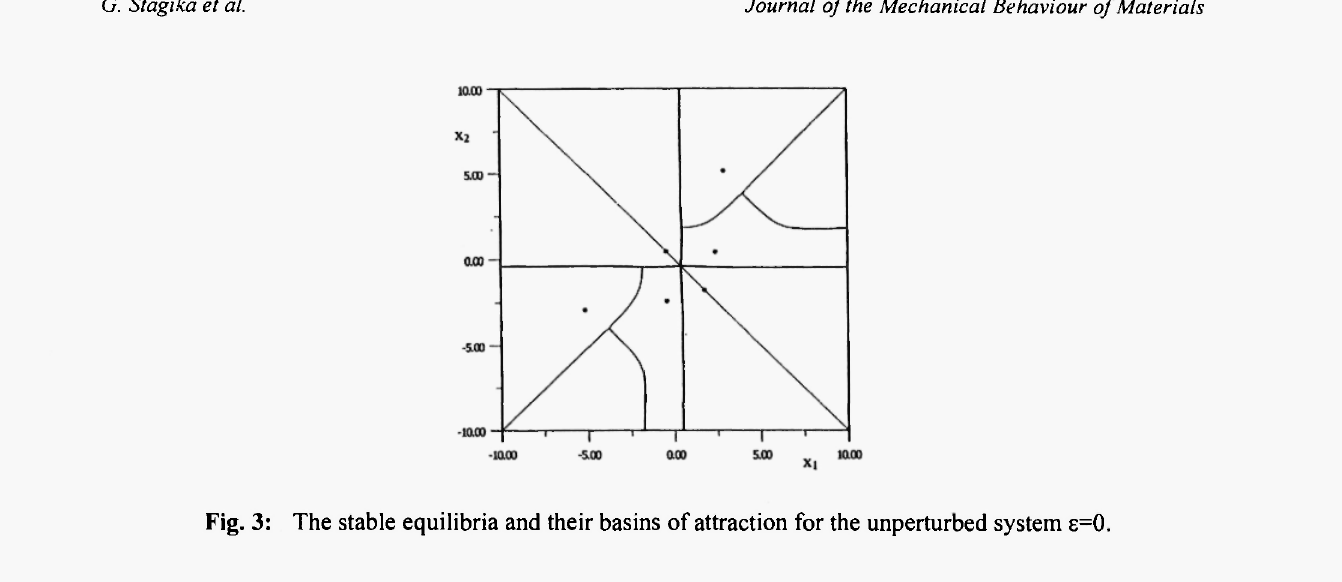
Fig. 3: The stable equilibria and their basins of attraction for the unperturbed system ε=0.